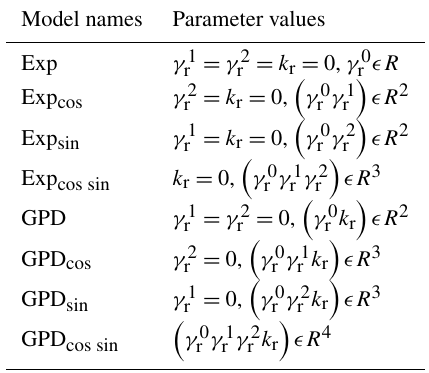
Table 3. Possible models for the fitting of the regional